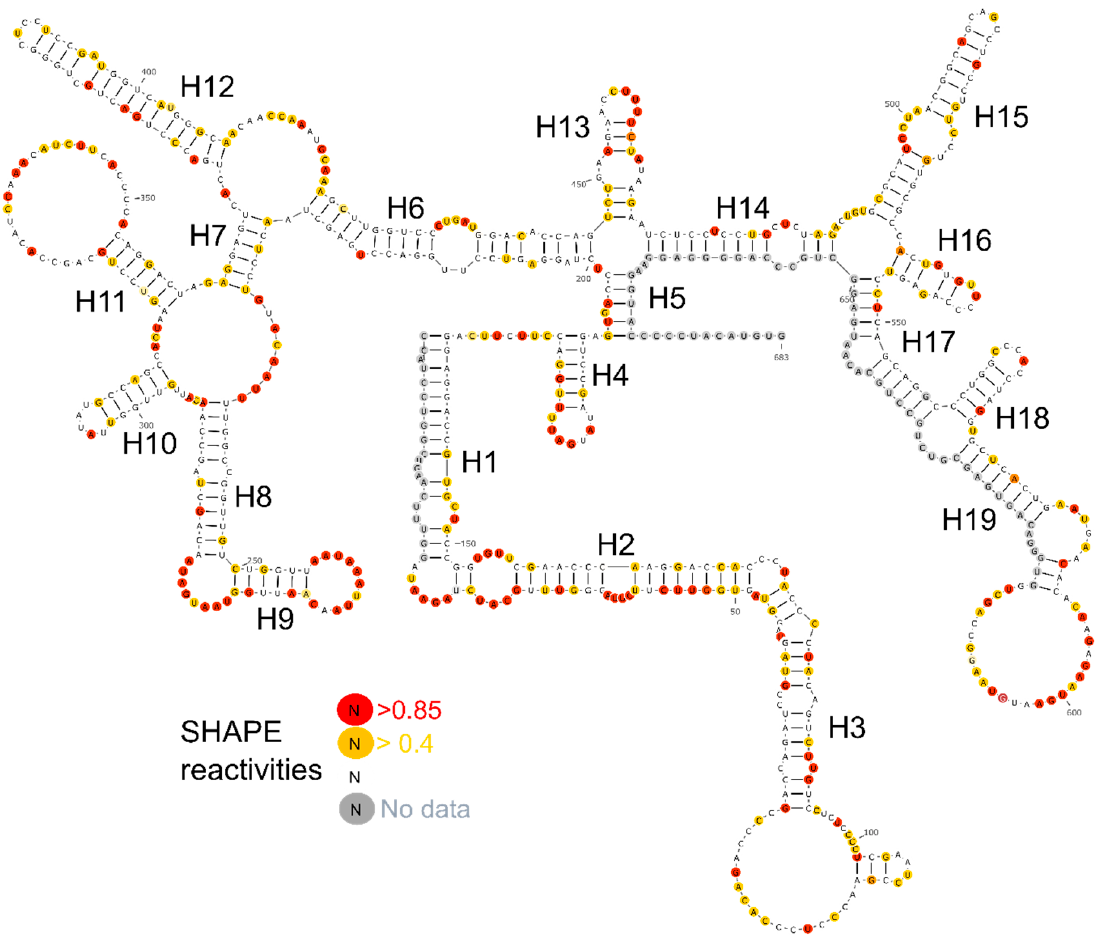
Figure 3. Secondary structure of lncTCF7. SHAPE reactivities are highlighted as depicted in the legend. Nucleotides with high SHAPE reactivity are highlighted in red, nucleotides with medium SHAPE reactivity are highlighted in yellow, and nucleotides with ‘no data’ are highlighted in grey.